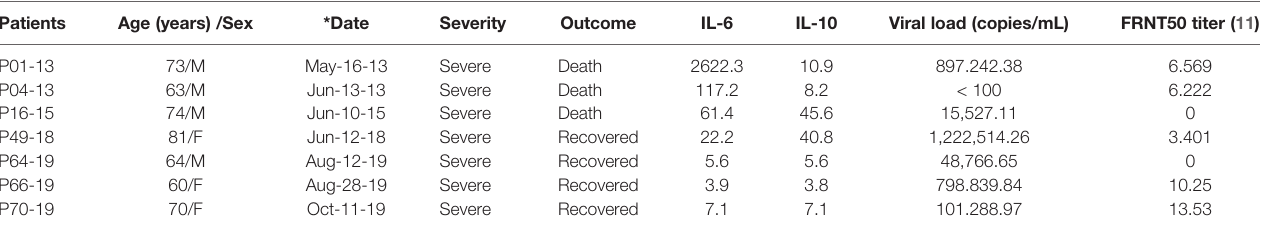
TABLE 3-1 | Comparison of IL-6 and IL-10 concentrations, viral load, and neutralizing antibody titers between patients with fatal severe disease and patients with nonfatal severe disease. Patients